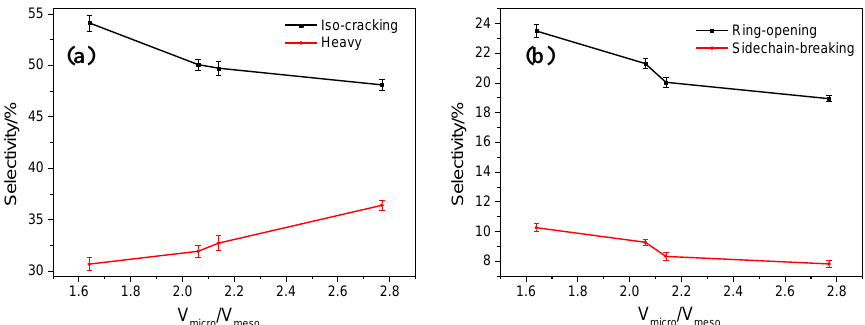
Figure 12. The path selectivity of SAZ zeolite at 60% conversion rate vs. V micro /V meso . ( a ) The selectivity of Iso-cracking and Heavy vs. V micro /V meso and ( b ) The selectivity of Ring-opening and Sidechain-breaking vs. V micro /V meso .